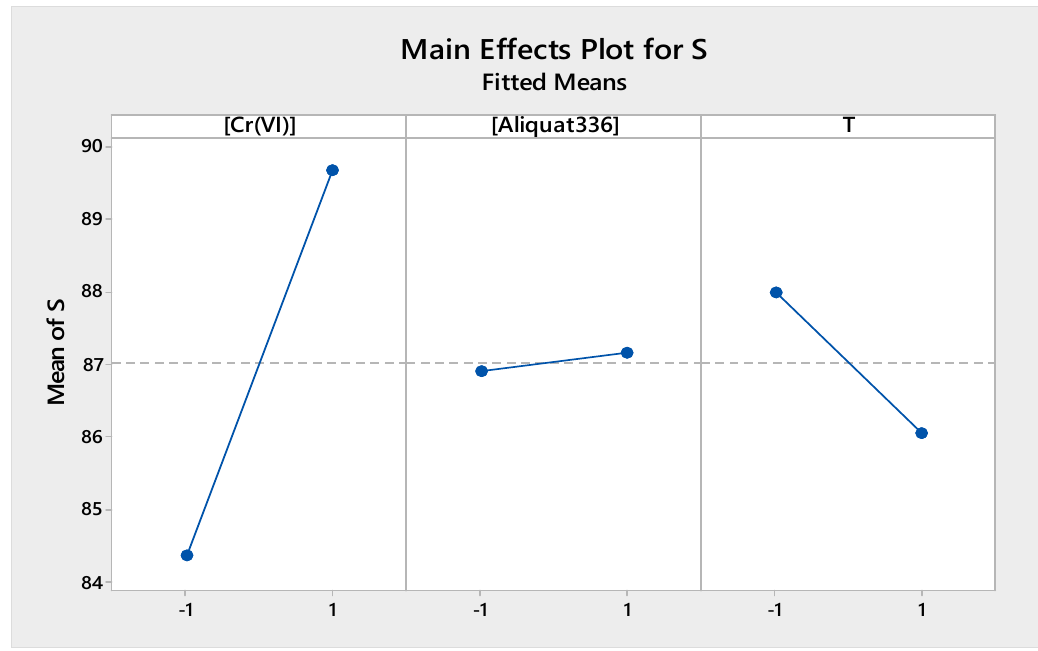
Figure 8. Factors of main effects plot for source phase.